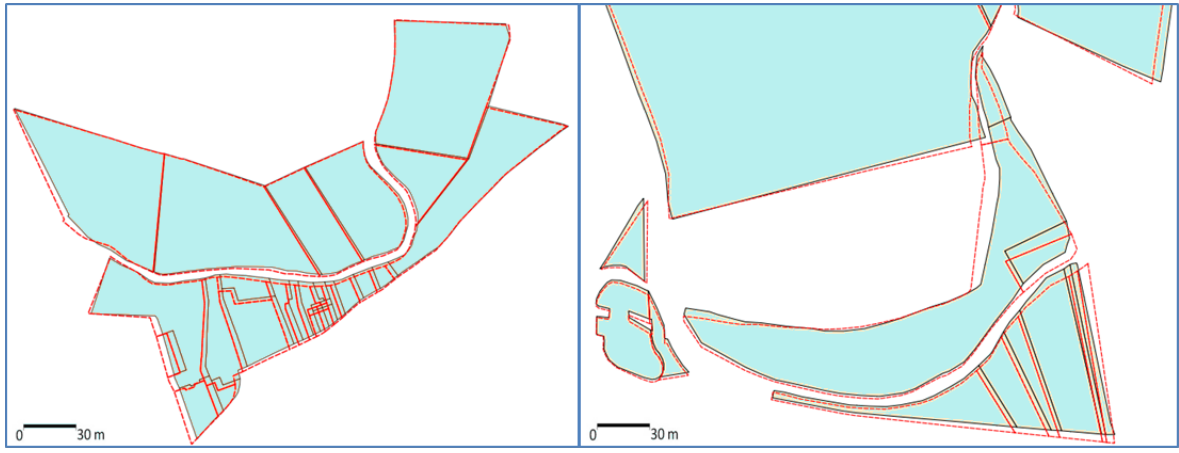
Figure 17. Zoomed extracts of the second conflated city: despite large distortions, complex shapes are well